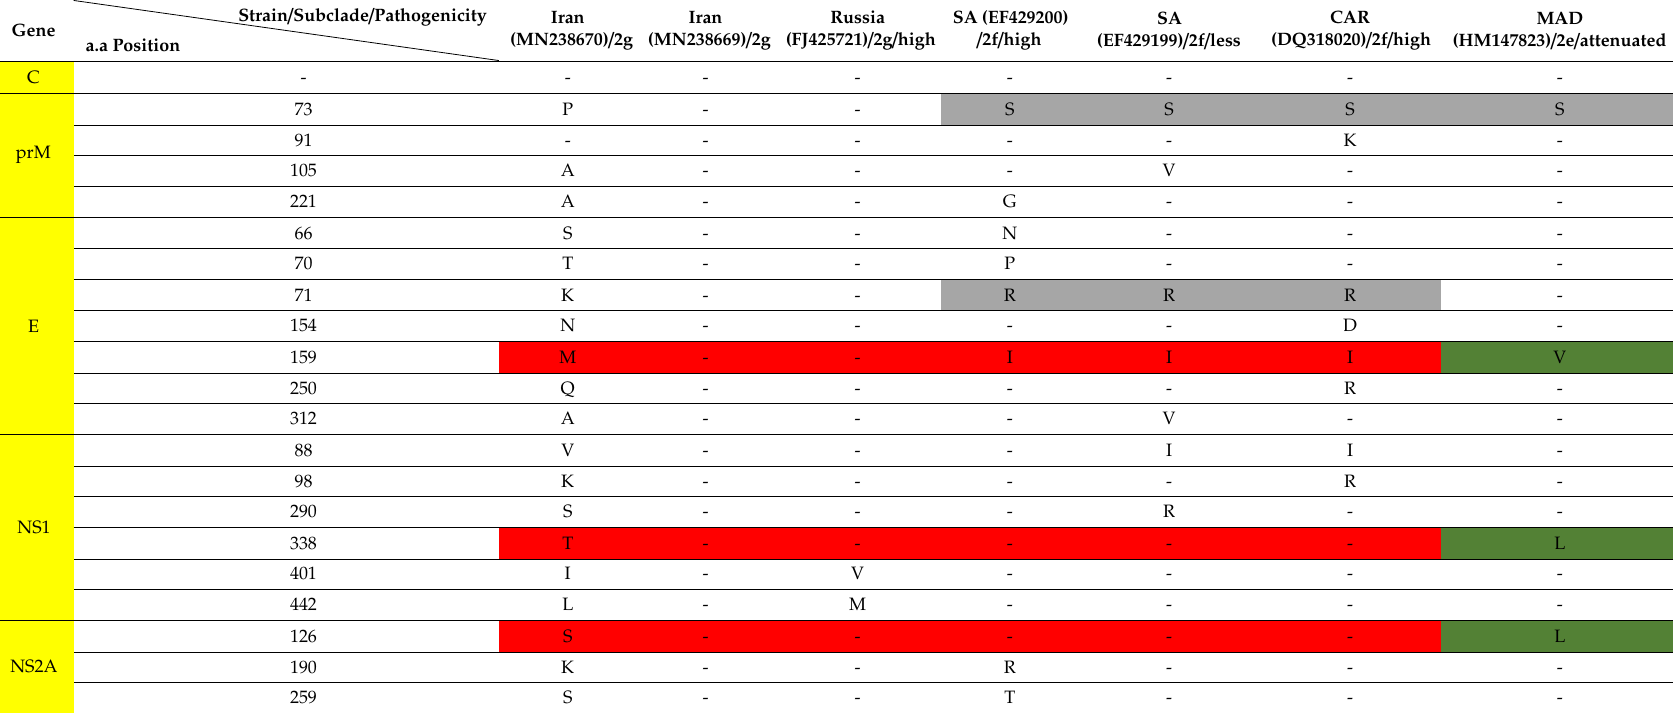
Table 2. Amino acid substitutions observed in two WNV strains obtained in this study compared with highly or less pathogenic variants in subclade 2f and subclade 2g and a strain from subclade 2e (Madagascar / HM147823) as a less pathogenic strain. Amino acid substitutions known as markers for neuroinvasiveness and less virulent phenotypes are shown in red and green, respectively and mutation sites known as adaptive evolution sites are shown in grey.